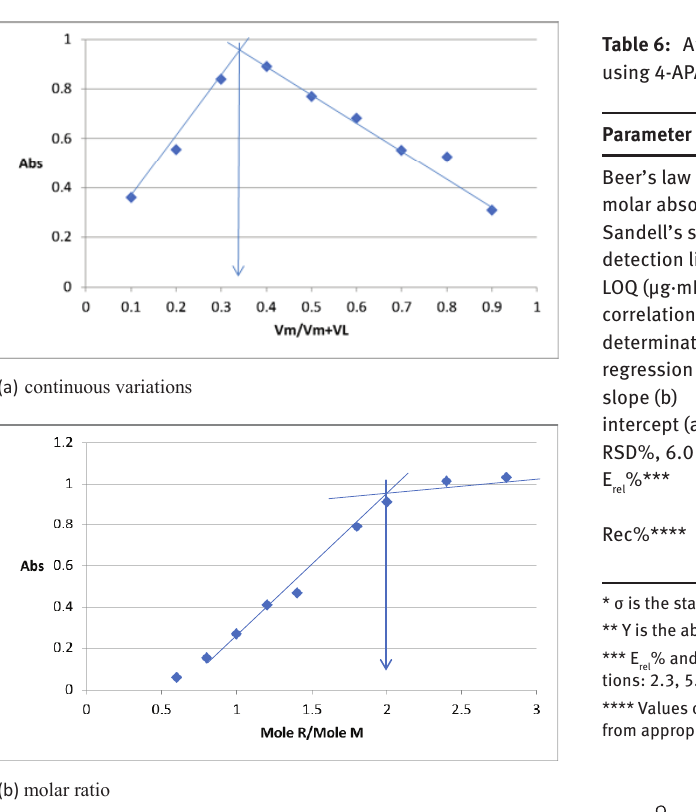
Figure 24: Methods of continuous variations (s) and molar ratio (b) for Bi 3+ complex at pH = 6.0.